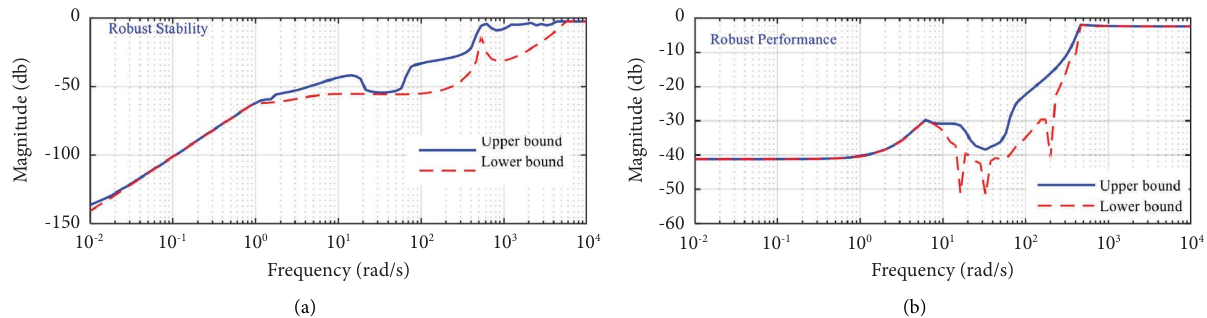
Figure 9: Te μ analysis for (a) robust stability and (b) robust performance for the augmented system in the presence of the proposed robust